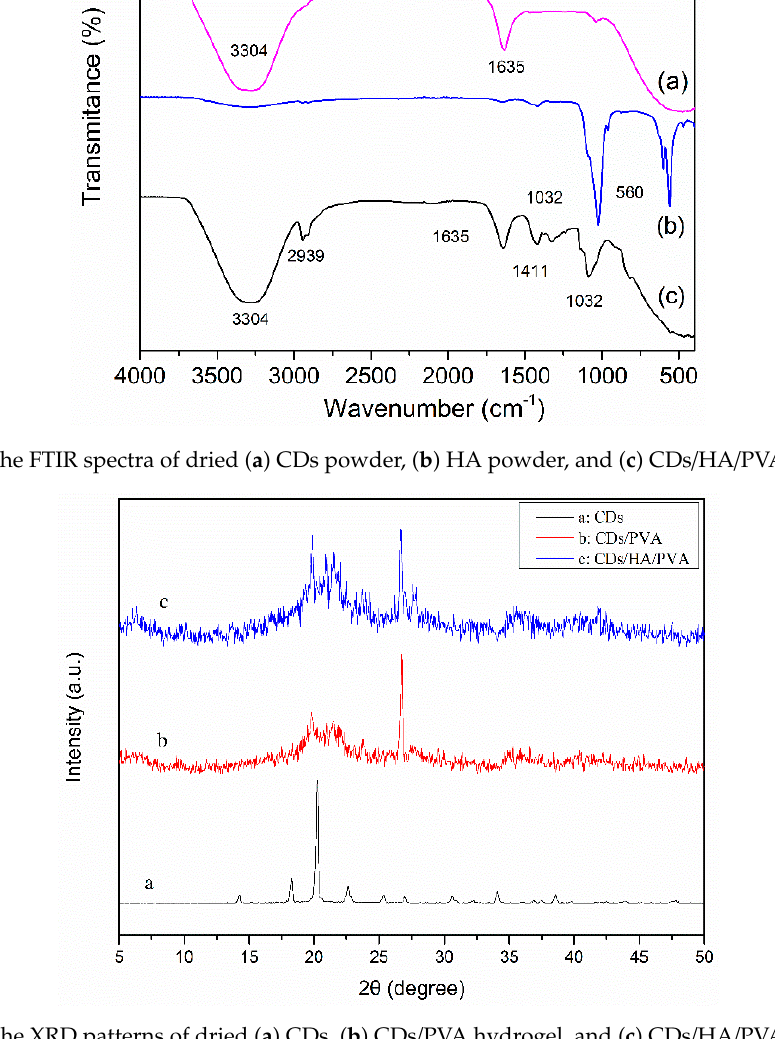
Figure 1. The FTIR spectra of dried ( a ) CDs powder, ( b ) HA powder, and ( c ) CDs/HA/PVA hydrogel.